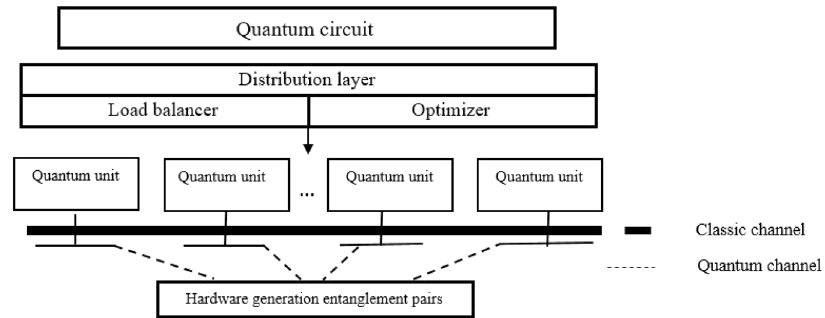
Figure 1. A multi-layer architecture of quantum